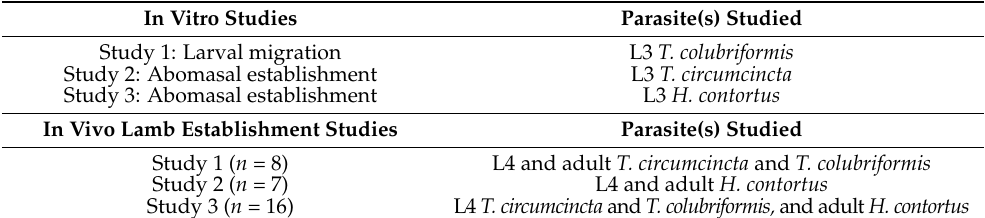
Table 1. Loline alkaloid effects on gastrointestinal nematodes trial